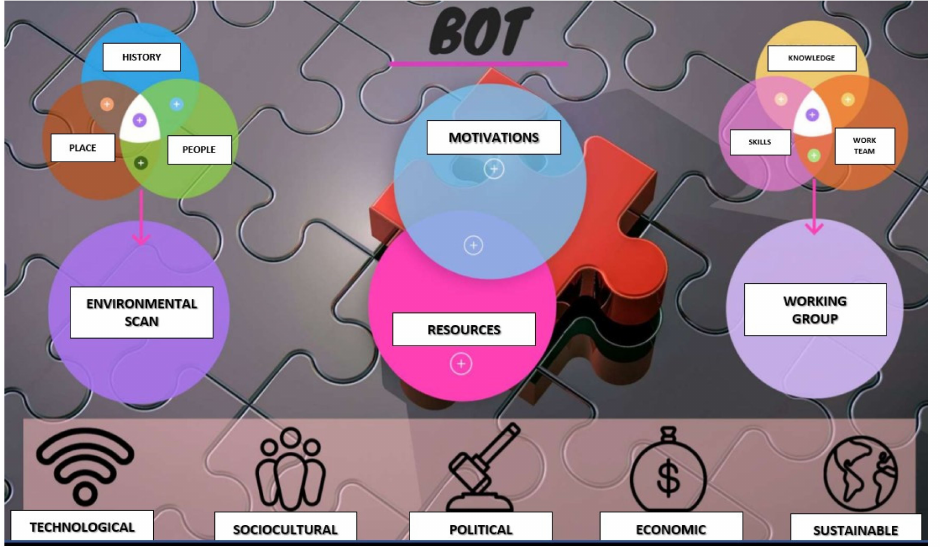
Figure 3. BOT tool. Source: own